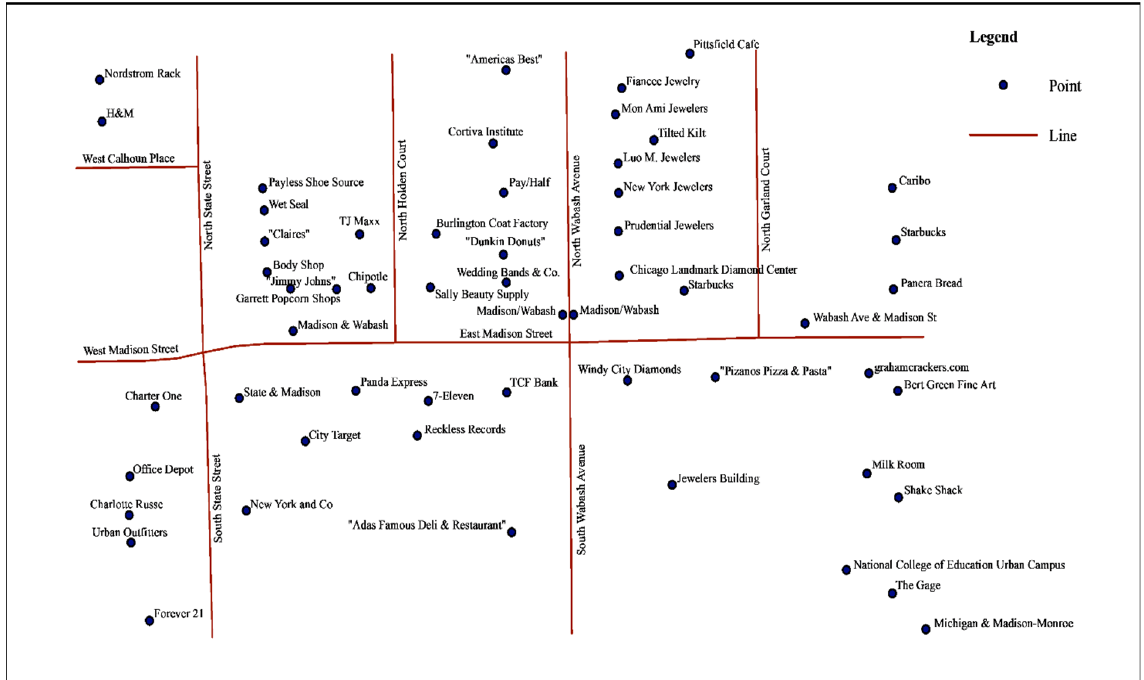
Figure 11. Result of the second dataset using the proposed algorithm.